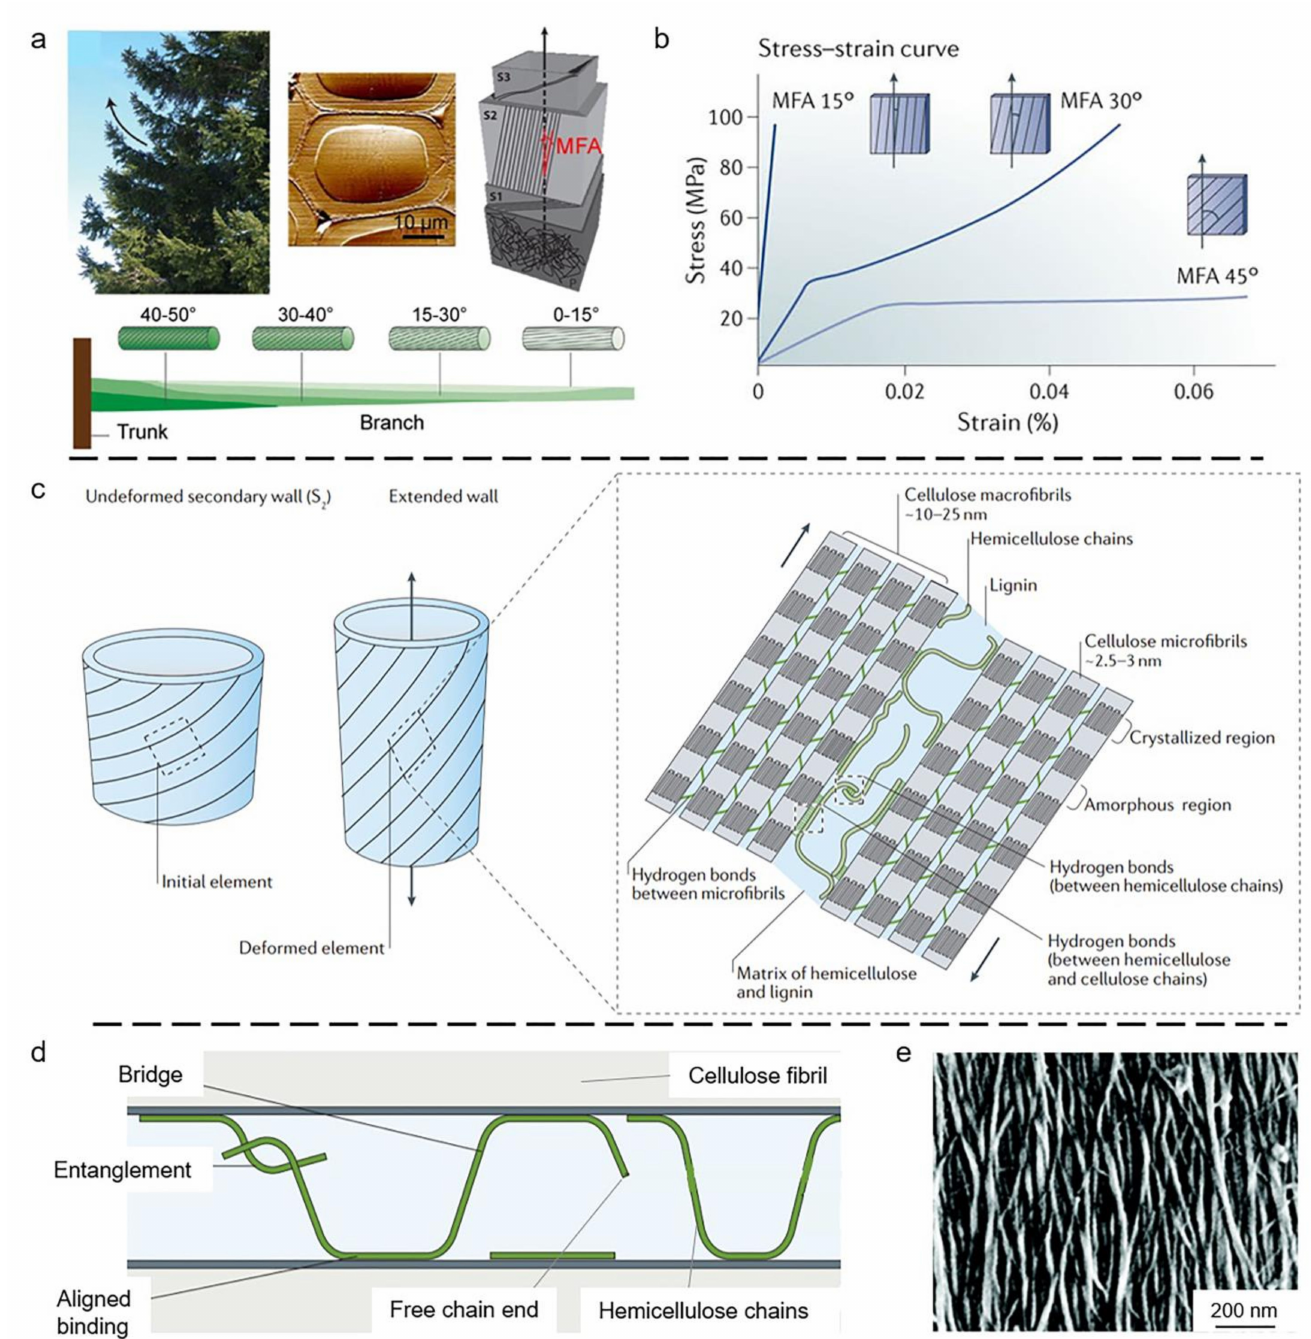
Figure 3. ( a ) Digital photograph and schematic of a tracheid in wood xylem. Reprinted with permission from [14], copyright 2017 PERGAMON-ELSEVIER SCIENCE LTD. ( b ) The stress–strain curves of the cell wall with different MFAs. Reprinted with permission from [47], copyright 2018 NATURE RESEARCH. ( c ) The deformation mechanism of a wood tracheid. ( d ) Hemicellulose chain segments within the interfibrillar space. Reprinted with permission from [21], copyright 2016 NATURE RESEARCH. ( e ) SEM image of cellulose microfiber in S2 layer of Ginkgo xylem. Reprinted with permission from [69], copyright 2014 ROYAL SOC